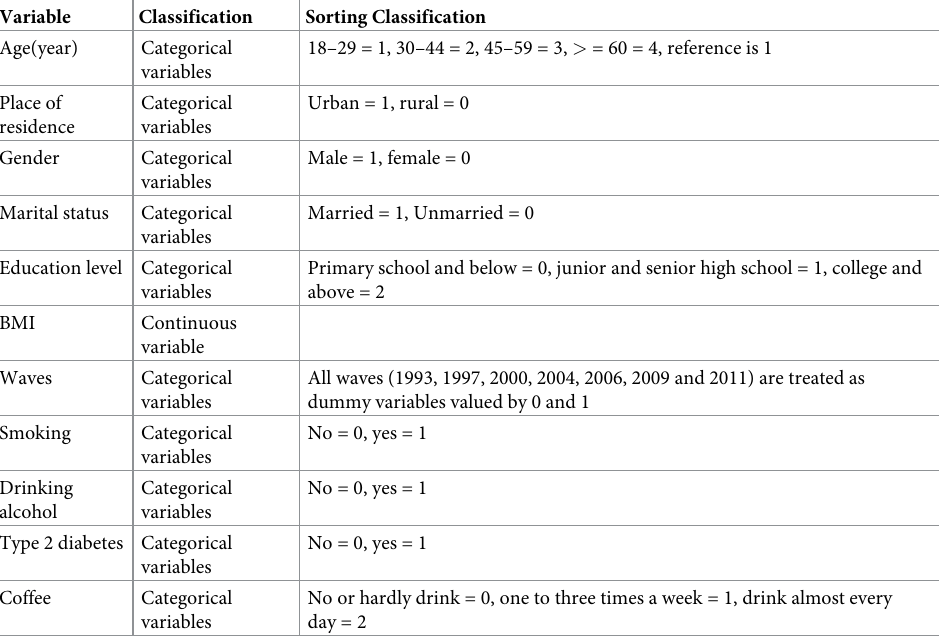
Table 1. The classification of model